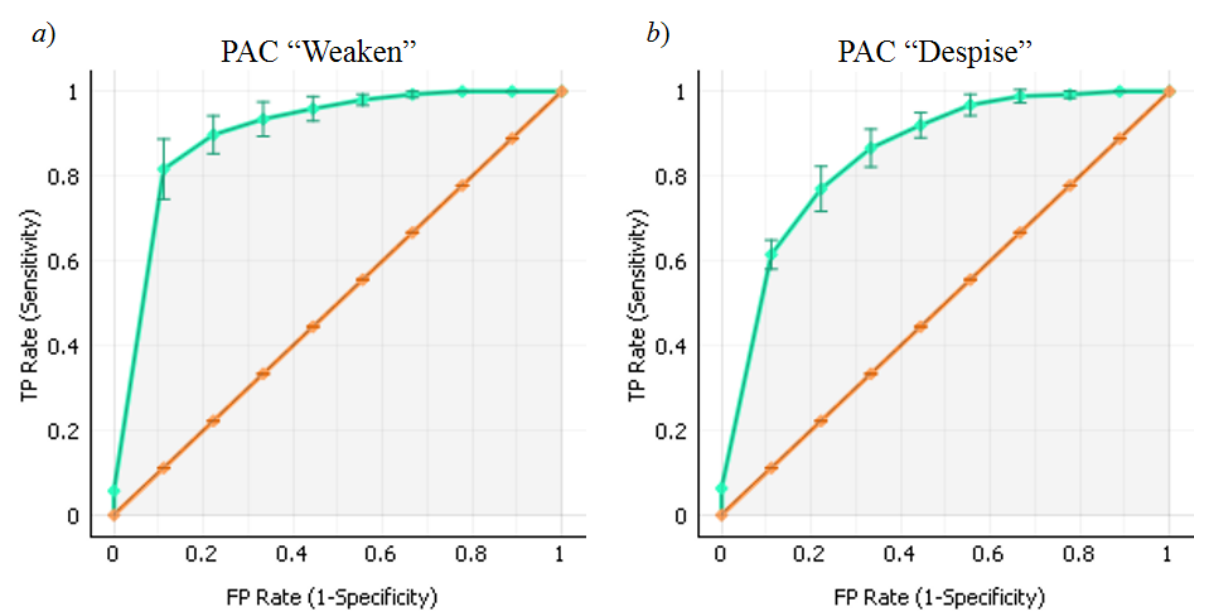
Figure 5. Comparison of ROC curves for the prediction of ( a ) PAC “Weaken” and ( b ) PAC “Des- pise”. Table 4. Average scores for class predictions using OvR classification and hyperparameter settings.